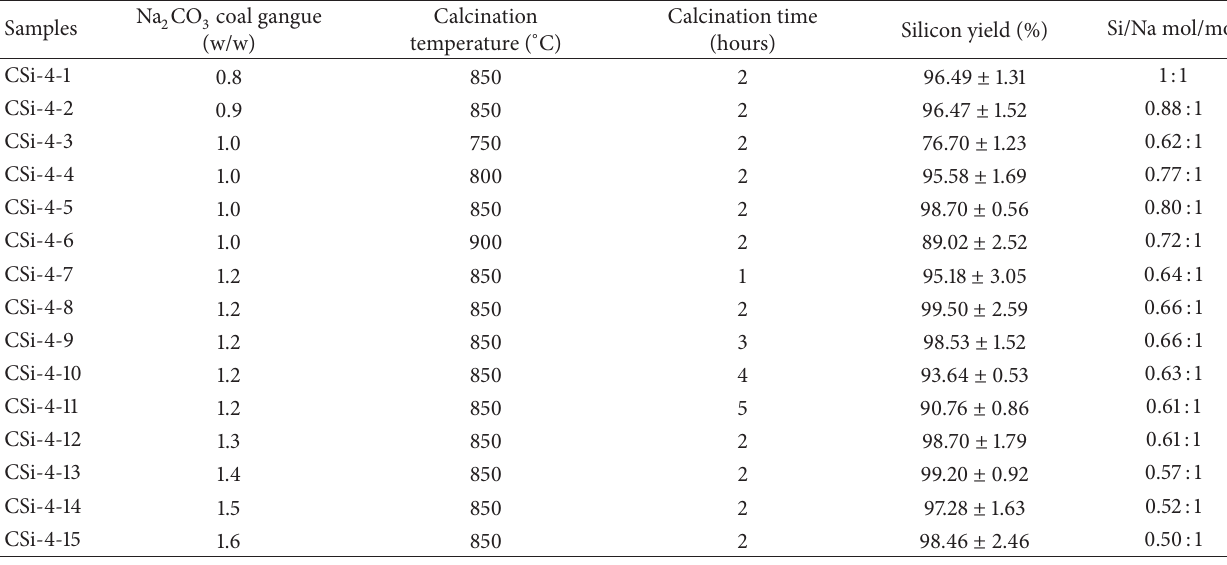
Table 3: Extraction of SiO 2 after chemical activation.